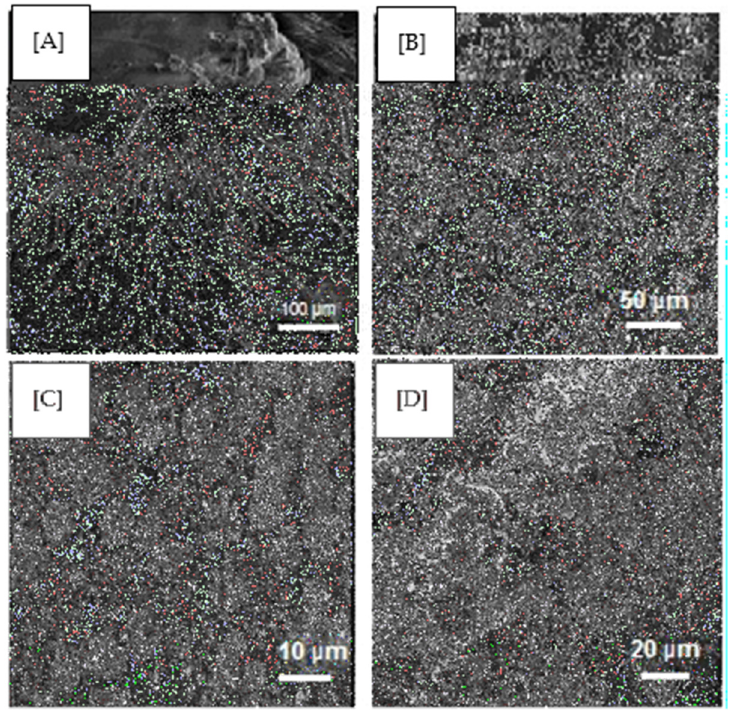
Figure 5. SEM images of ( A ) GS, ( B ) Keratin, ( C ) 1:3 composite scaffold ( D ) 1:4 composite scaffold.